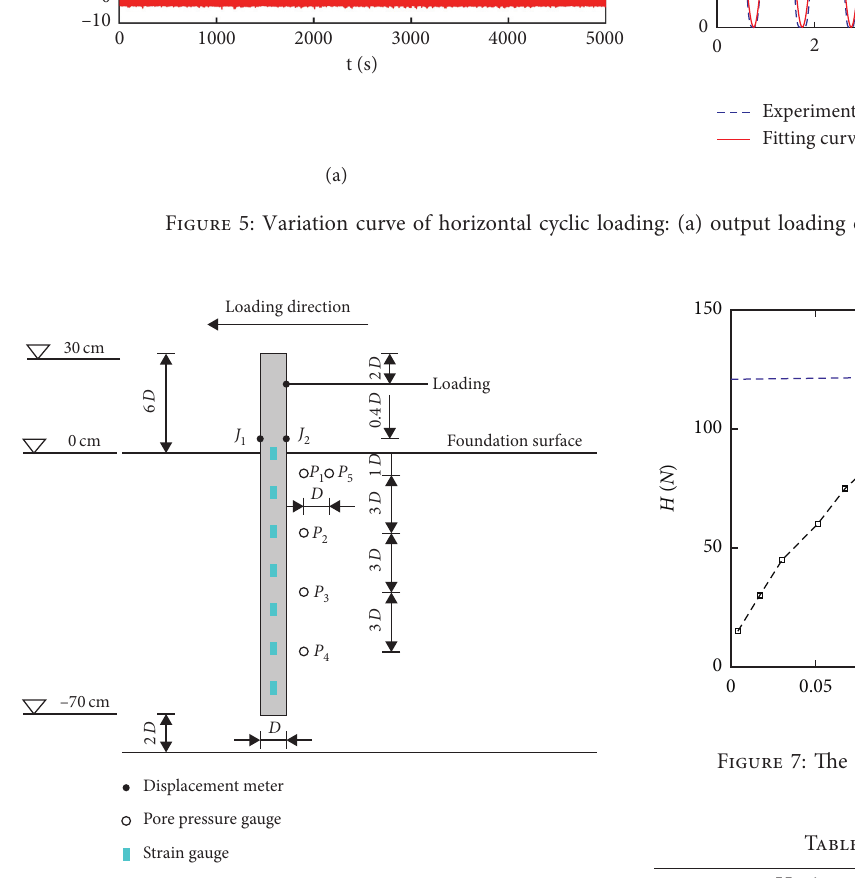
Figure 6: The sensor layout.